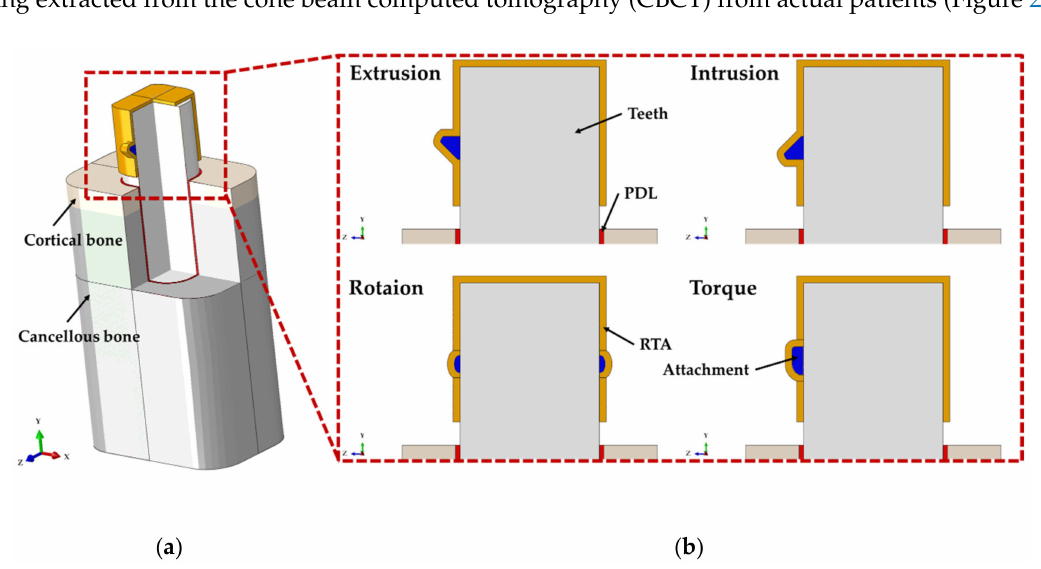
Figure 2. Finite element model built for each of the 4 orthodontic treatment situations. ( a ) Assembled model with bones, teeth, periodontal ligament (PDL), attachment, and removable thermoplastic aligner (RTA). ( b ) Extrusion, intrusion, rotation, and torque